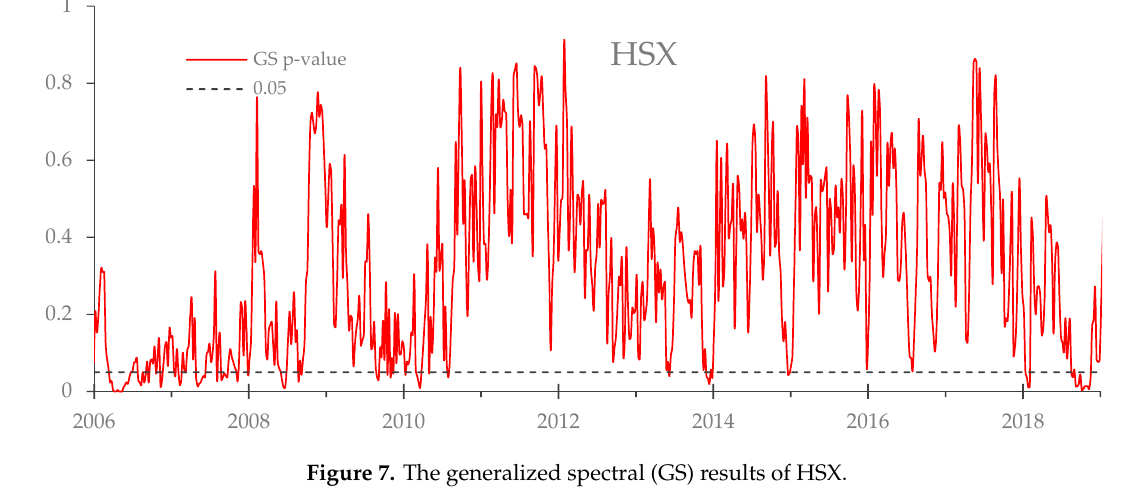
Figure 7. The generalized spectral (GS) results of HSX.